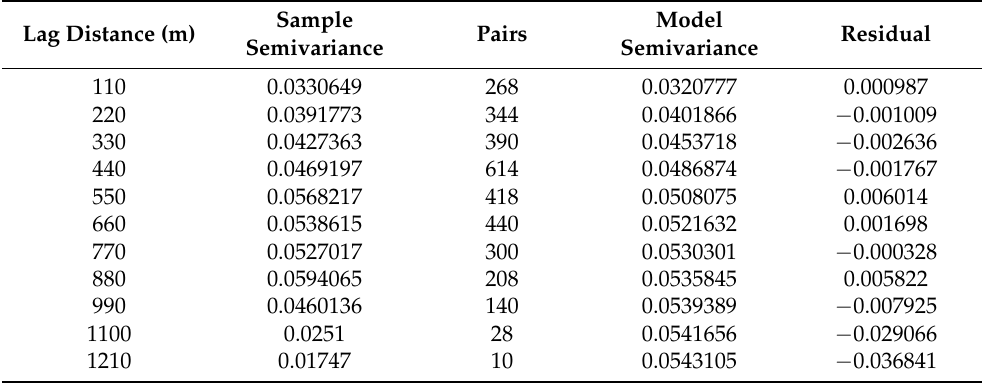
Table 4. Helen Springs sample and exponential model